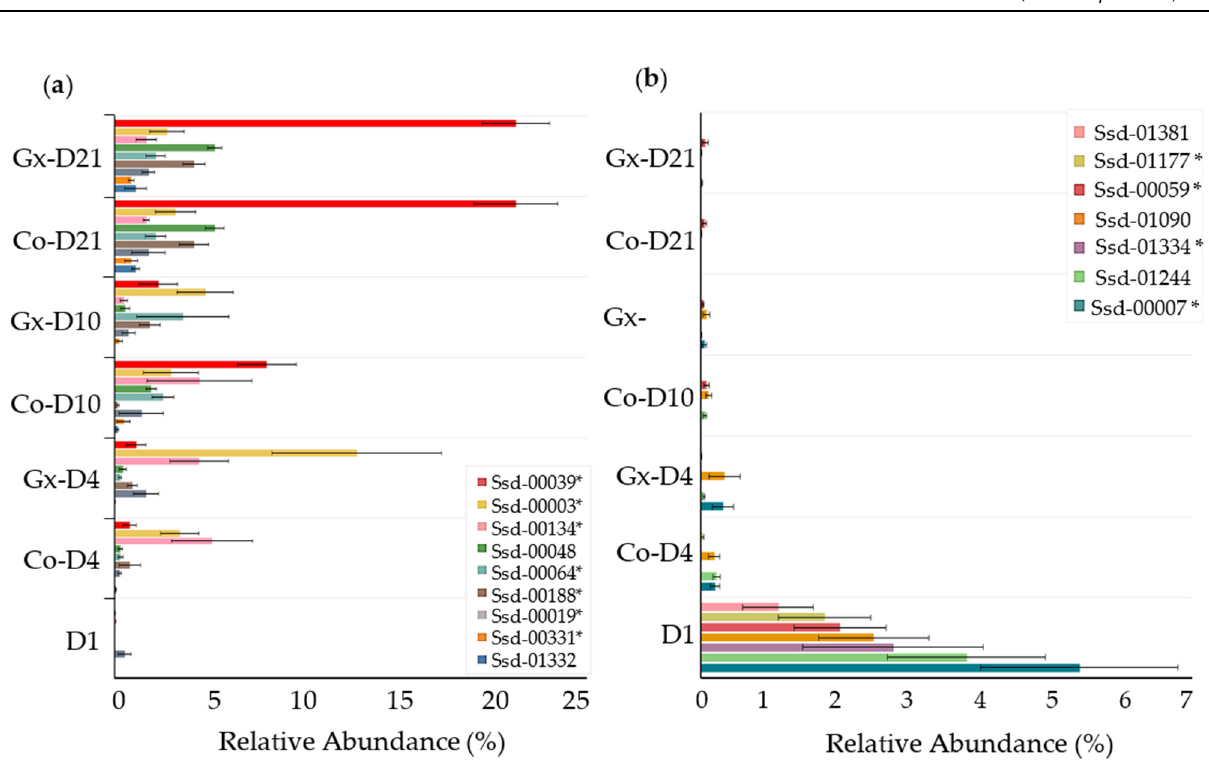
Figure 4. Bar graph comparing the respective abundances of select OTUs across supplemented (Gx) or non-supplemented (Co) groups at different time points. ( a ) OTUs increasing from D1 to D21 ( p < 0.05). ( b ) OTUs decreasing from D1 to D21 ( p < 0.05). * OTUs with 97% identity or greater to their respective closest valid taxa.